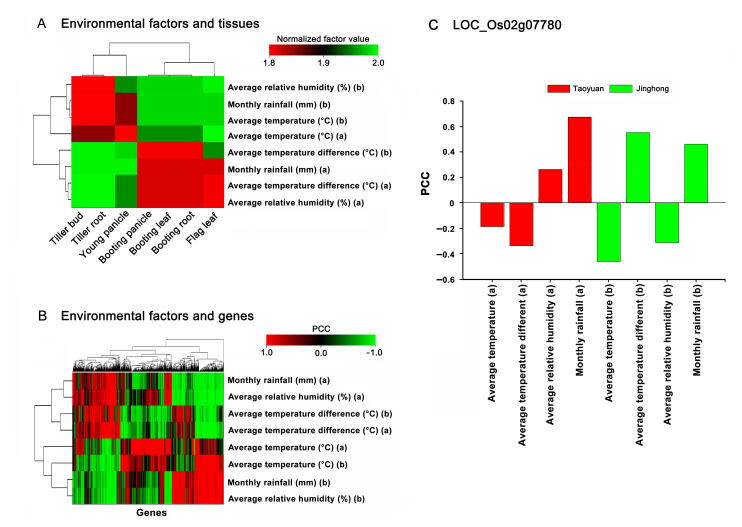
Environmental factors and gene expression. A. Clustering of environmental factors based on their observed values, e.g., in the heatmap matrix, each element represents the value of one environmental factor tested at one sampling time. Here, (a) represents the environmental factor observed at Taoyuan, and (b) represents the environmental factor observed at Jinghong. Other factors have similar labels. B. Clustering of environmental factors based on their associations with genes, e.g., in this heatmap matrix, each element indicates PCC between one environmental factor and one gene in the samples from Taoyuan (a) or Jinghong (b). C. The associations between environmental factors and a candidate key yield-associated gene LOC_Os02g07780 (OsSPL4). This gene is negatively associated with the average temperature difference but positively correlated with average relative humidity at Taoyuan, which is reversed at Jinghong. Thus, these factors would reflect important environmental differences between Taoyuan (a) and Jinghong (b), and the associated gene OsSPL4 is likely a candidate key yield-associated gene responding to such environmental changes. PCC, Pearson’s correlation coefficient.